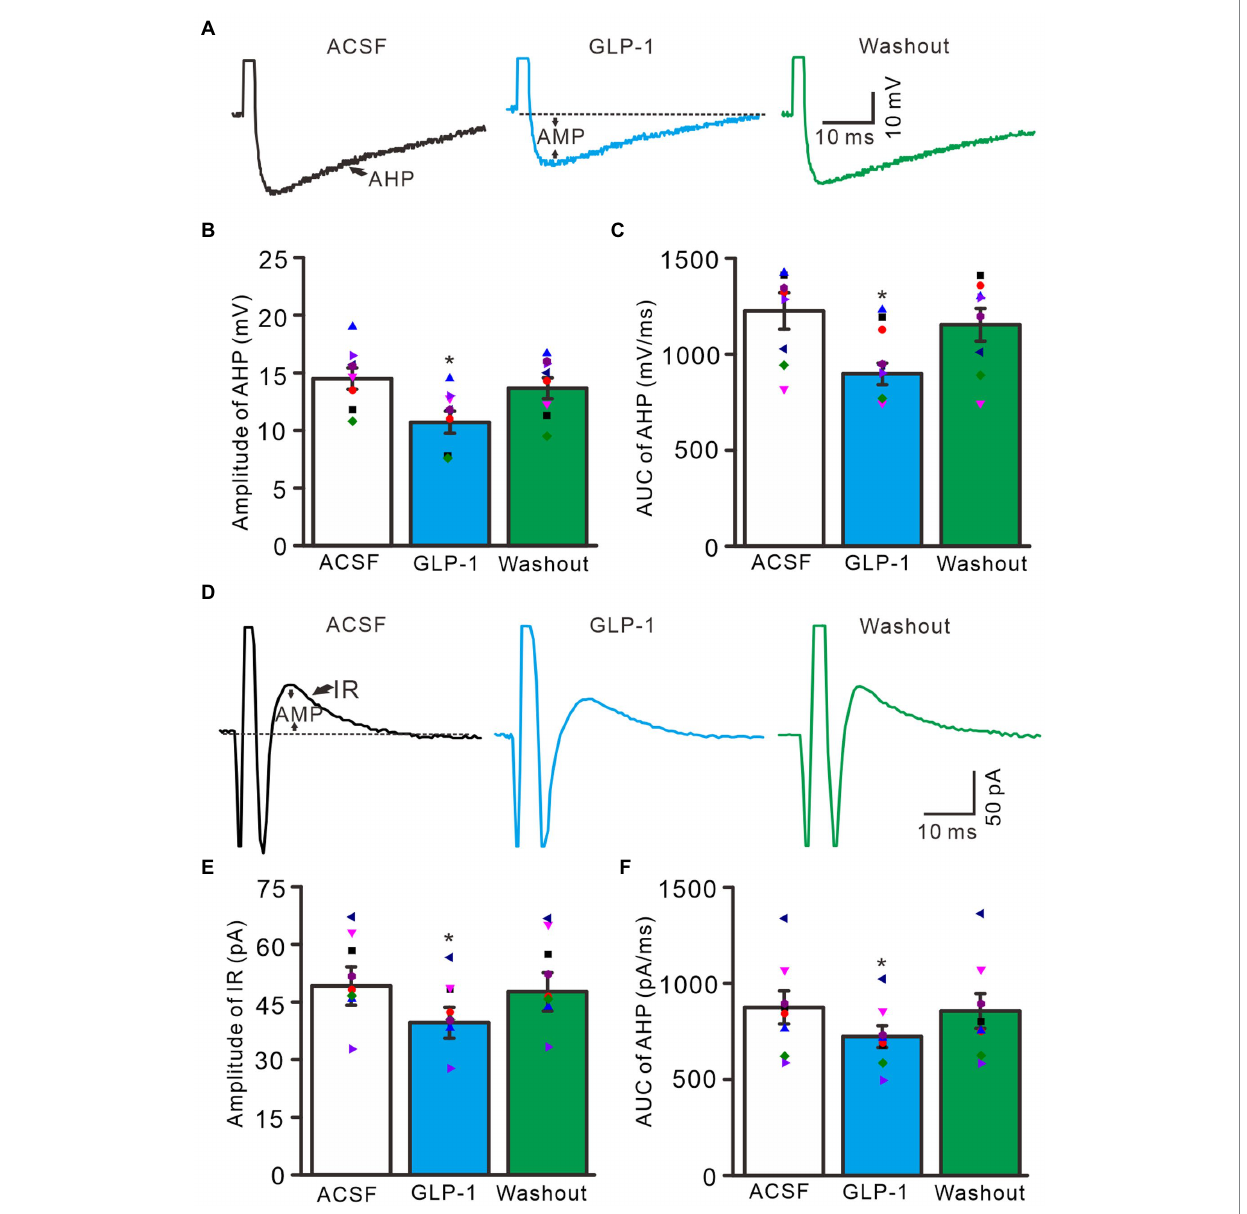
FIGURE 4 Effect of GLP-1 on after-hyperpolarization (AHP) of the depolarization currents-evoked action potential. (A) Representative traces showing AHP of the depolarization currents (10 pA, 1 ms)-evoked action potentials during treatments of ACSF, GLP-1 (100 nM), and washout. (B) The mean (± S.E.M) with individual data showing the amplitude of AHP during treatments with ACSF, GLP-1 and washout. (C) The mean (± S.E.M) with individual data showing the area under the curve (AUC) of AHP during each treatment. (D) Representative traces showing outward rectified current (IR) of the evoked simple spike discharge during each treatment. (E) The mean (± S.E.M) with individual data showing the amplitude of IR during each treatment. (F) The mean (± S.E.M) with individual data showing AUC of IR during each treatment. * p < 0.05 vs. ACSF, n = 8 cells in each